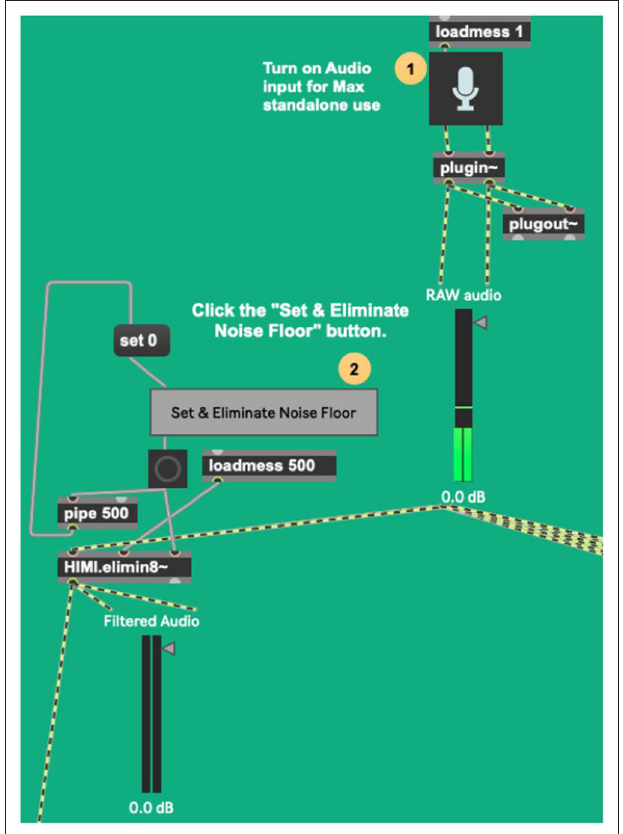
FIGURE 6 | The process beneath sig2 ∼ ’s noise floor elimination apparatus.